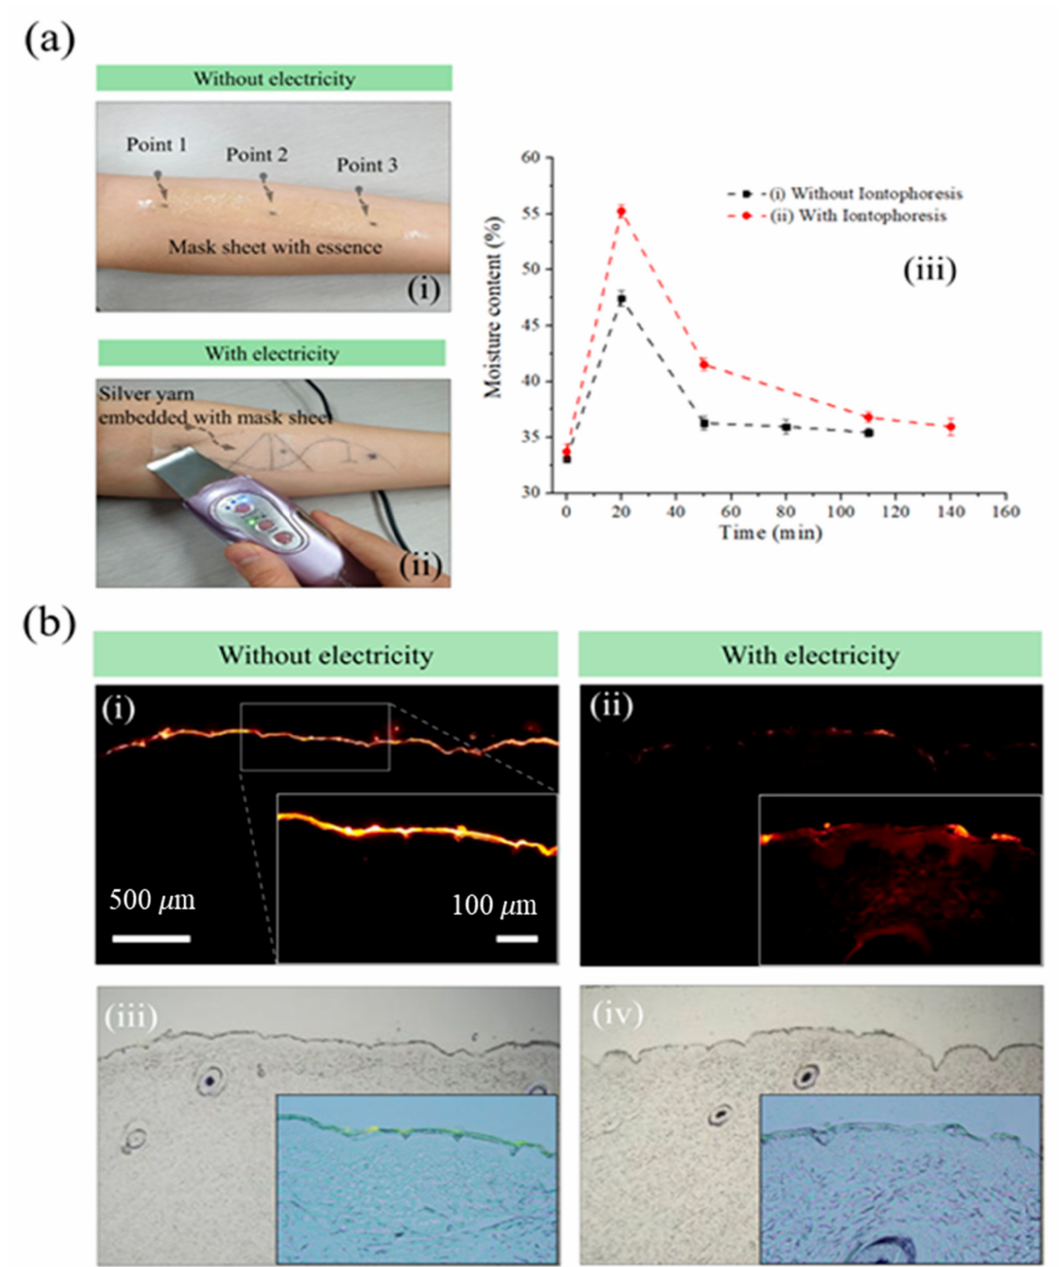
Figure 3. Iontophoresis effects. ( a ) Actual experimental images ( i ) without electricity and ( ii ) with electricity, and ( iii ) comparison of moisture content (%) with and without electricity. ( b ) Fluores- cence and merged optical images with and without electricity for electrically assisted facial mask. ( i , iii ) Without electricity, and ( ii , iv ) with electricity (scale bars: 500 µ m, 100 µ